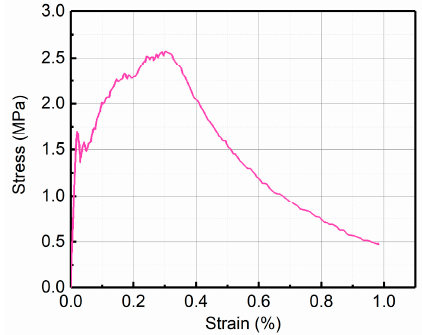
Figure 2. The stress–strain behavior of the SHCC in uniaxial tension.